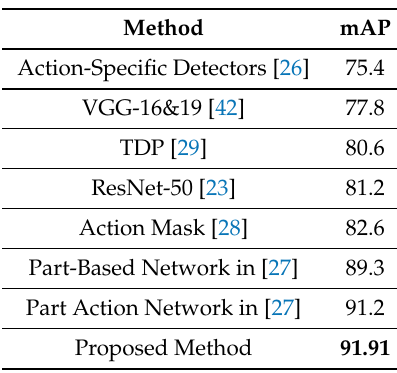
Table 4. Comparison of mAP with other methods on the Stanford 40 Actions Dataset [15]. Bold font indicates the best result.